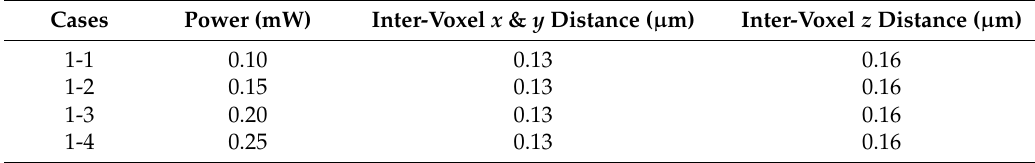
Table 1. Fabrication parameter combinations with different laser powers.